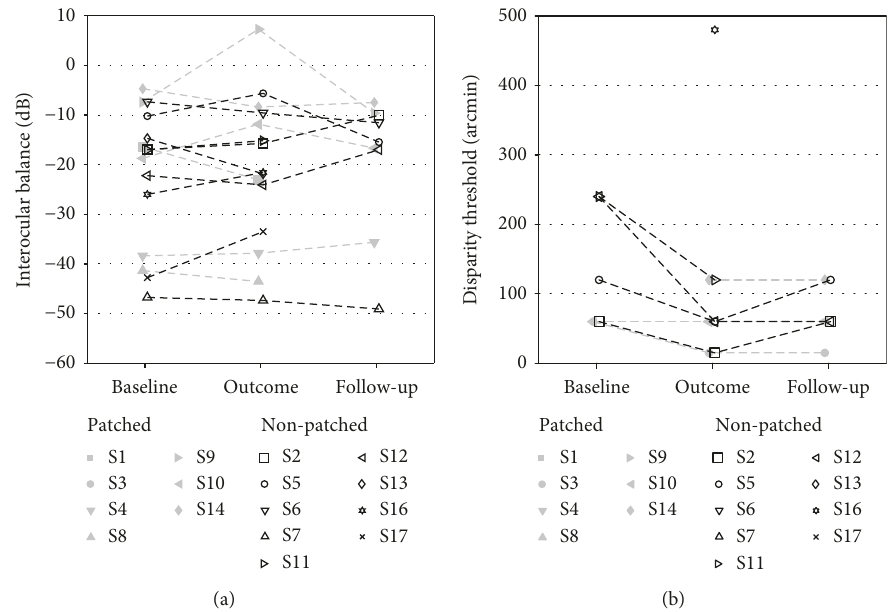
Figure 5: E ff ect of training on binocular vision. (a) Interocular balance amblyopic/nonamblyopic eye expressed in dB at baseline, at the outcome, and at the follow-up of the training. (b) Disparity sensitivity threshold at baseline, at the outcome, and at the follow-up of the training. Participants from the patched group are indicated with fi lled grey symbols, and participants of the nonpatched group with open black